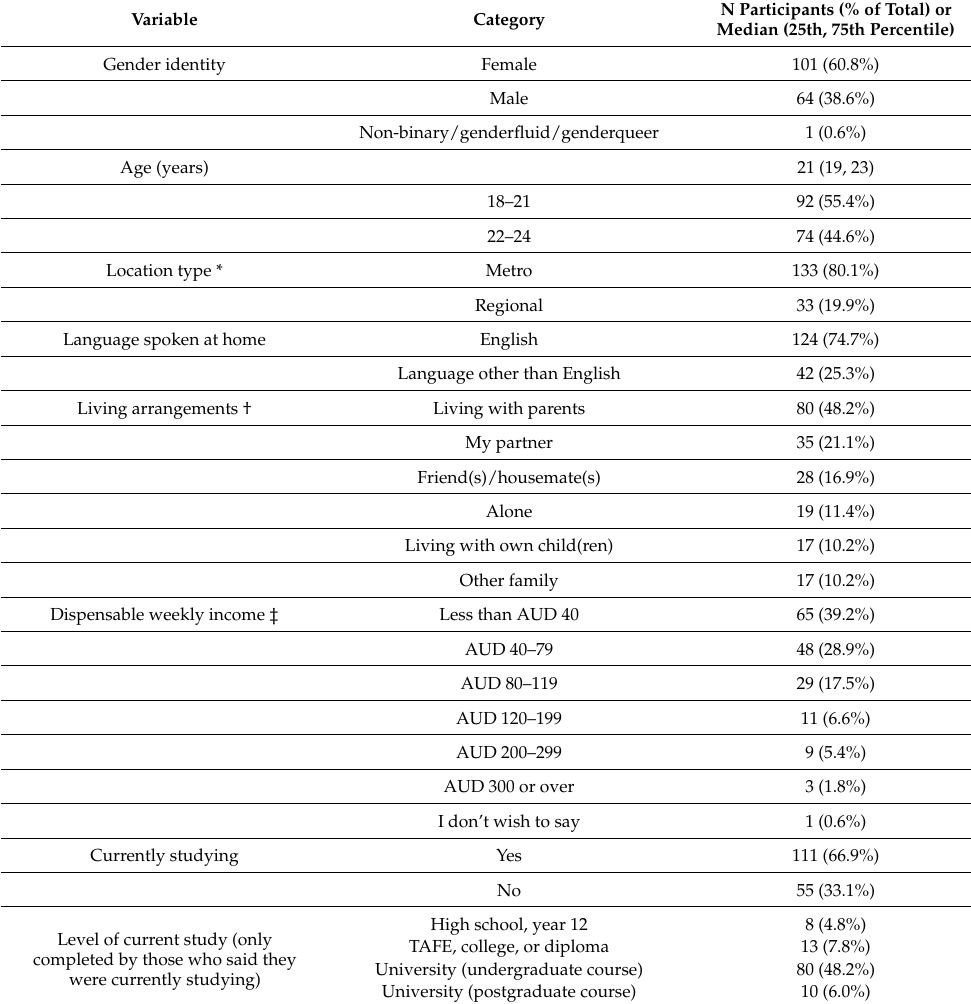
Table 2. Participant characteristics of those completing either Forum 3 or Forum 12 or both ( n = 166